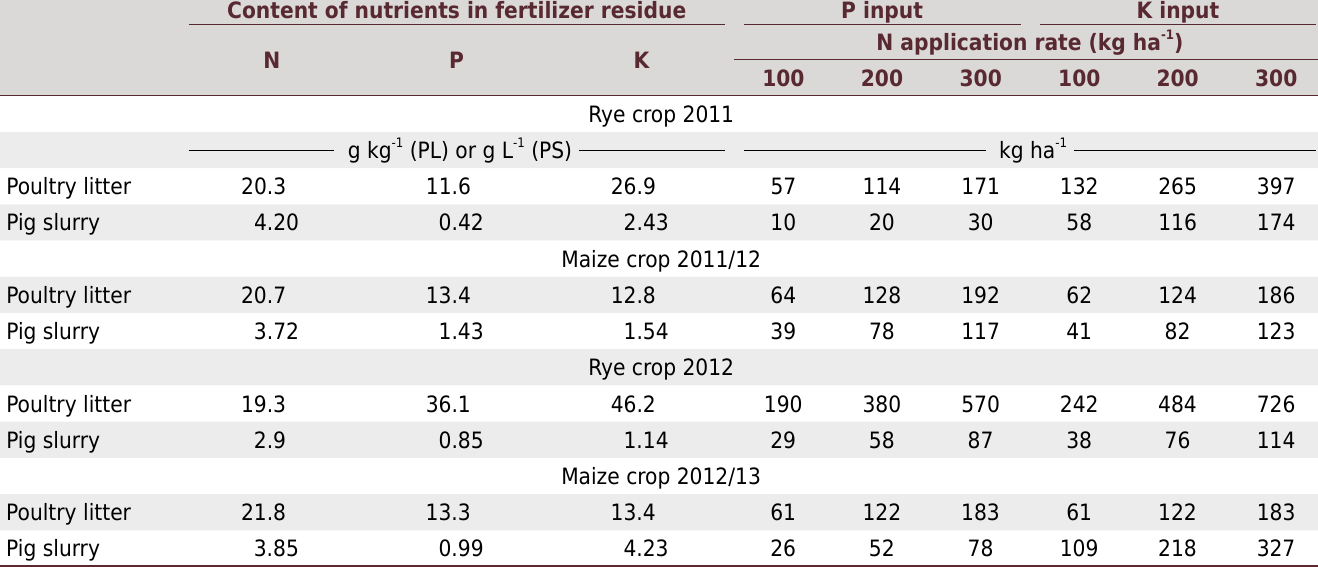
Table 2. Nitrogen, phosphorus, and potassium contents in poultry litter (PL) and pig slurry (PS) and phosphorus and potassium inputs in cropping systems Content of nutrients in fertilizer